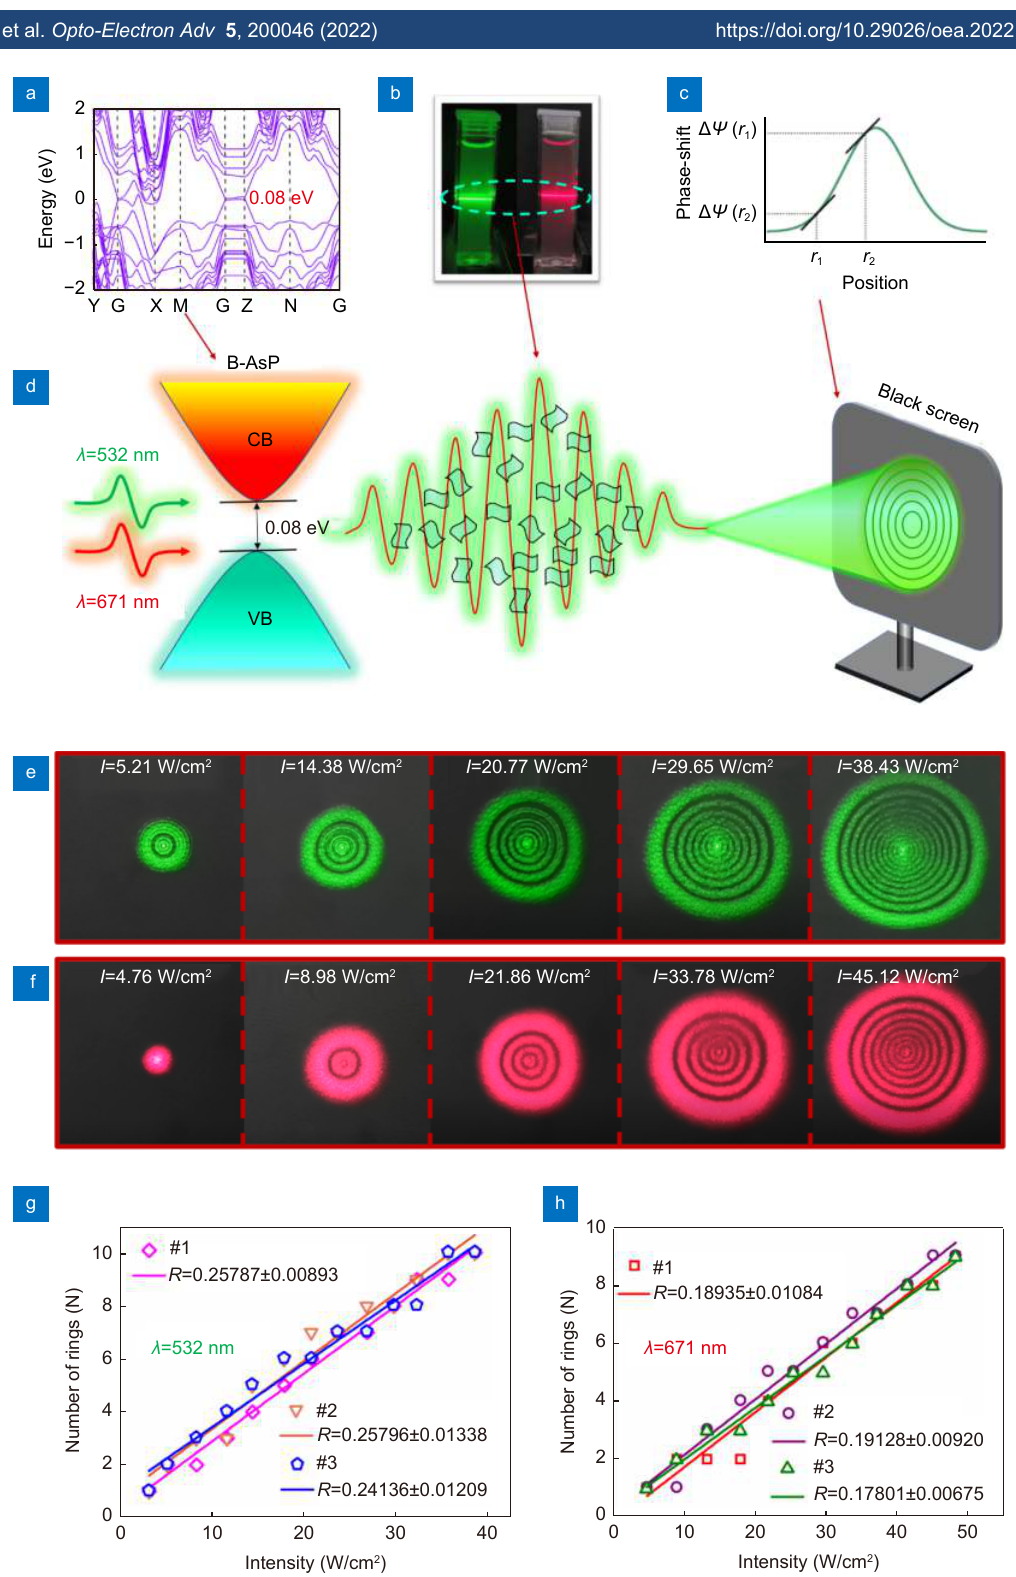
Fig. 3 | ( a ) The band gap structure of the B-As x P 1- x ( x = 0.4) NSs. ( b ) The 2D B-AsP NSs dispersions used in our experiment, and the Tyndall ef- fect observed as the laser beams transmitted through the sample. ( c ) The phase-shift of the incident light caused by the Kerr nonlinearity in 2D B-AsP NSs. ( d ) Experimental schematic of the SSPM based on the 2D B-AsP NSs dispersions. ( e , f ) The intensity-dependent diffraction patterns generated from the 2D B-AsP NSs dispersions with the lasers of λ = 532 nm and 671 nm, respectively. ( g , h ) The nonlinear optical response ( R ) for the 2D B-AsP NSs dispersions with three repeated measurements at λ = 532 nm and 671 nm,